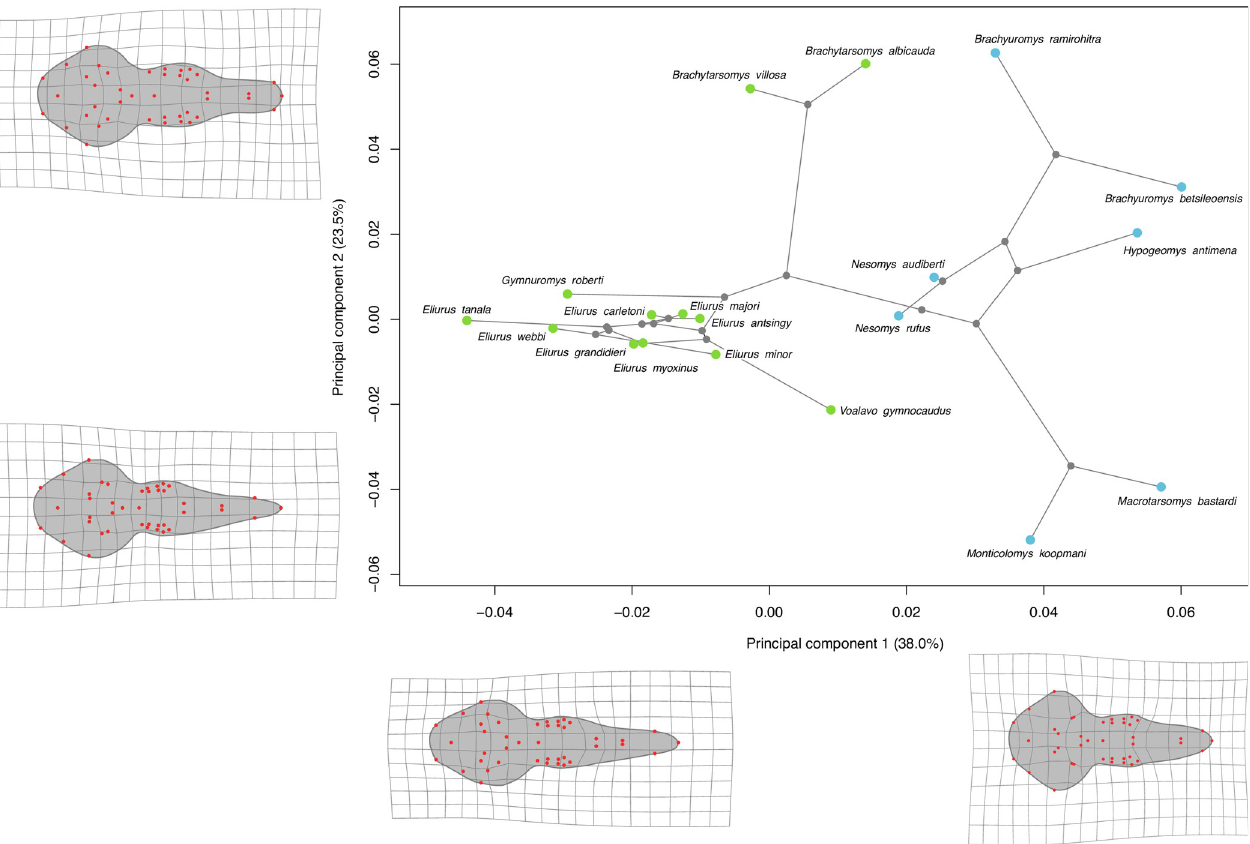
Fig 3. Visualization of the two first axes of the PCA performed on ventral shape with phylogenetic projection. Colored points represent the morphological average of all individuals of a species. Colors indicate the two principal clades among Nesomyinae. Blue: clade formed by the genus Brachyuromys , Nesomys , Macrotarsomys , Monticolomys , and Hypogeomys ; green: clade formed by the genus Brachytarsomys , Eliurus , Gymnuromys , and Voalavo . Warpgrids indicate shape variation along axis with maximum deformation observed at each extremity of the axis.